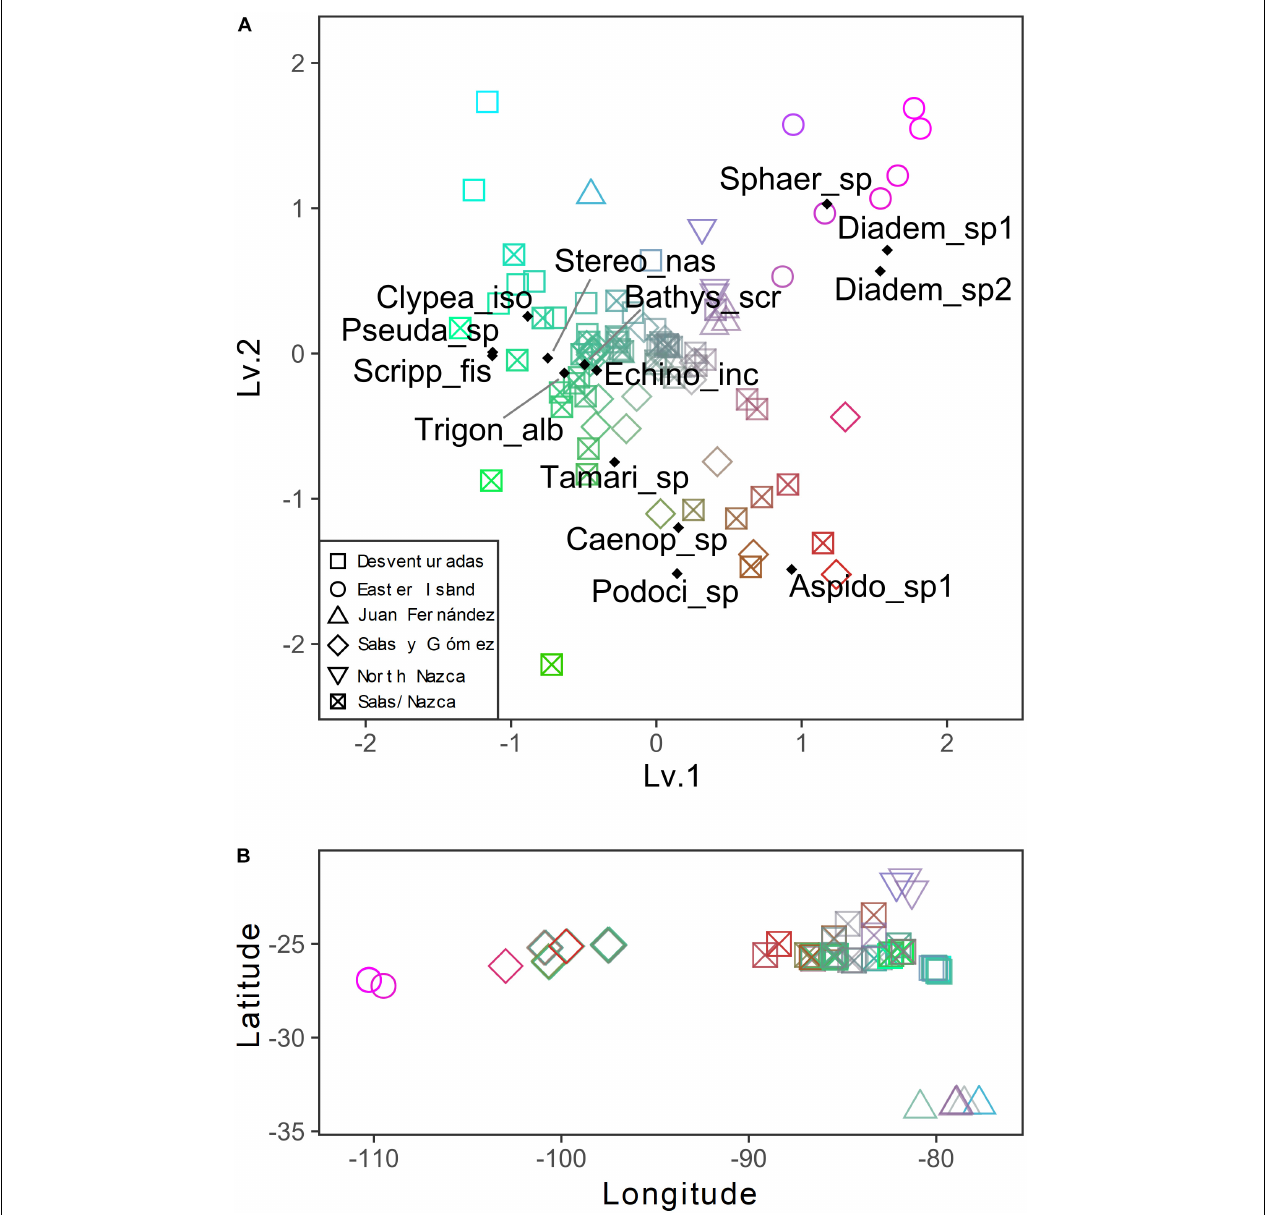
FIGURE 5 | (A) Unconstrained ordination derived from a pure latent variable modeling describing the variation patterns among stations of echinoderm assemblage structure across the southeastern Pacific. The color gradient represents the similarities in the axis scores: color indicates stations with similar assemblages. Colors are assigned from a 2D color space delimited by the two latent variables (axes). Species scores are shown. (B) Spatial changes in species composition are expressed by the color gradient of panel A (similar colors indicate similar